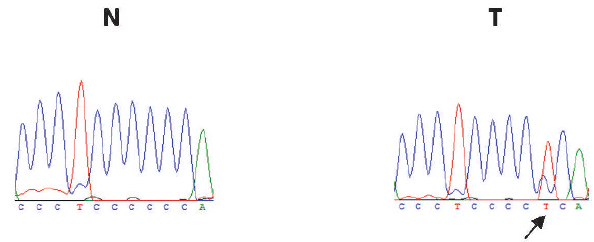
Figure 3 - Detection of the mtDNA somatic mutation (16192 CC/T) in a case of breast cancer. The arrow indicates the mutation. N: normal tissue; T: tumor tissue.